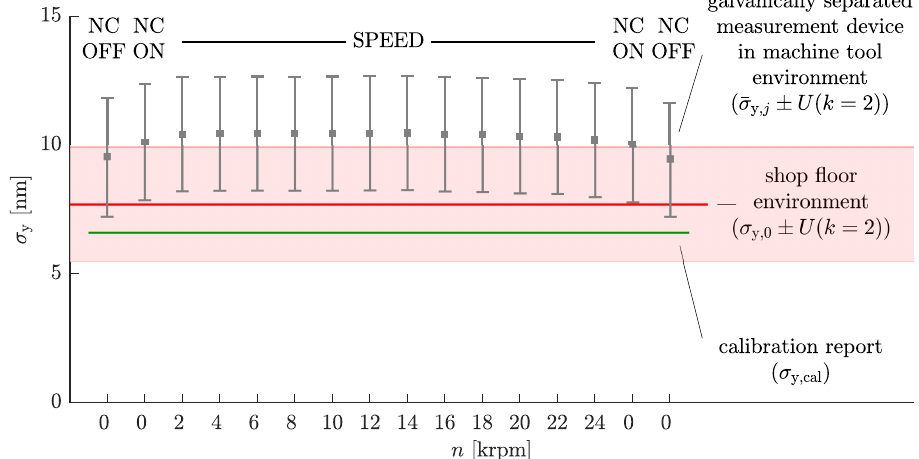
Figure 15. Repeatability test of galvanically separated measurement device tested in the environments of Machine Tool A and under different machine tool operating